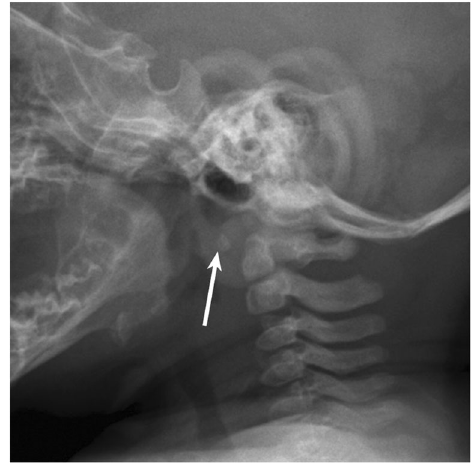
Fig. 2 Normal lateral radiograph of the cervical spine in a 13 month old reveals the ossification centre of the body of the atlas. The posterior arches have not yet